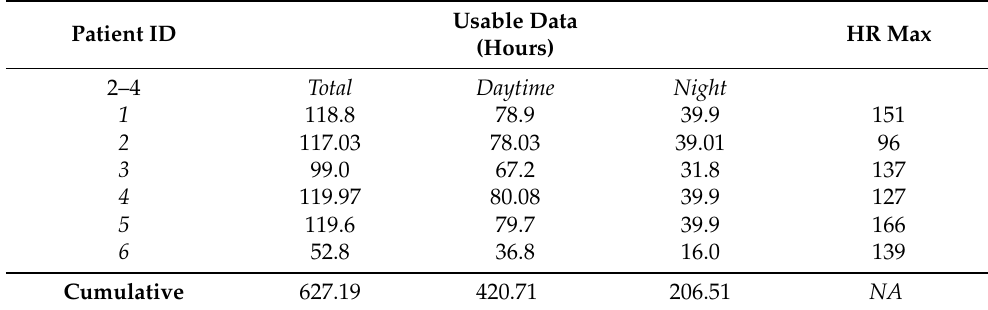
Table 3. Available data in hours, split also into daytime (assumed from 7 a.m. to 11 p.m.) and night (assumed from 11 p.m. to 7 a.m.). The last column contains the HR max reached during the stress test by each patient. NA stands for Not